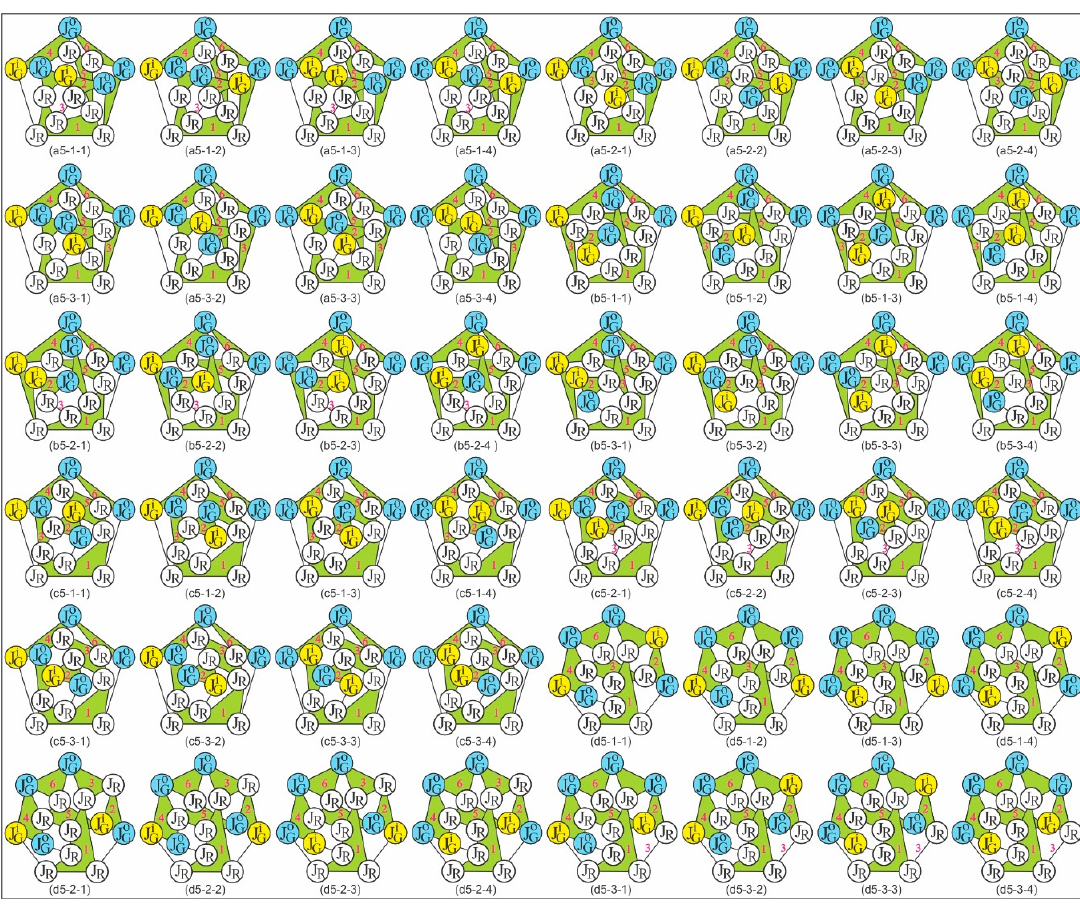
Figure 9. Atlas of feasible specialized kinematic chains.